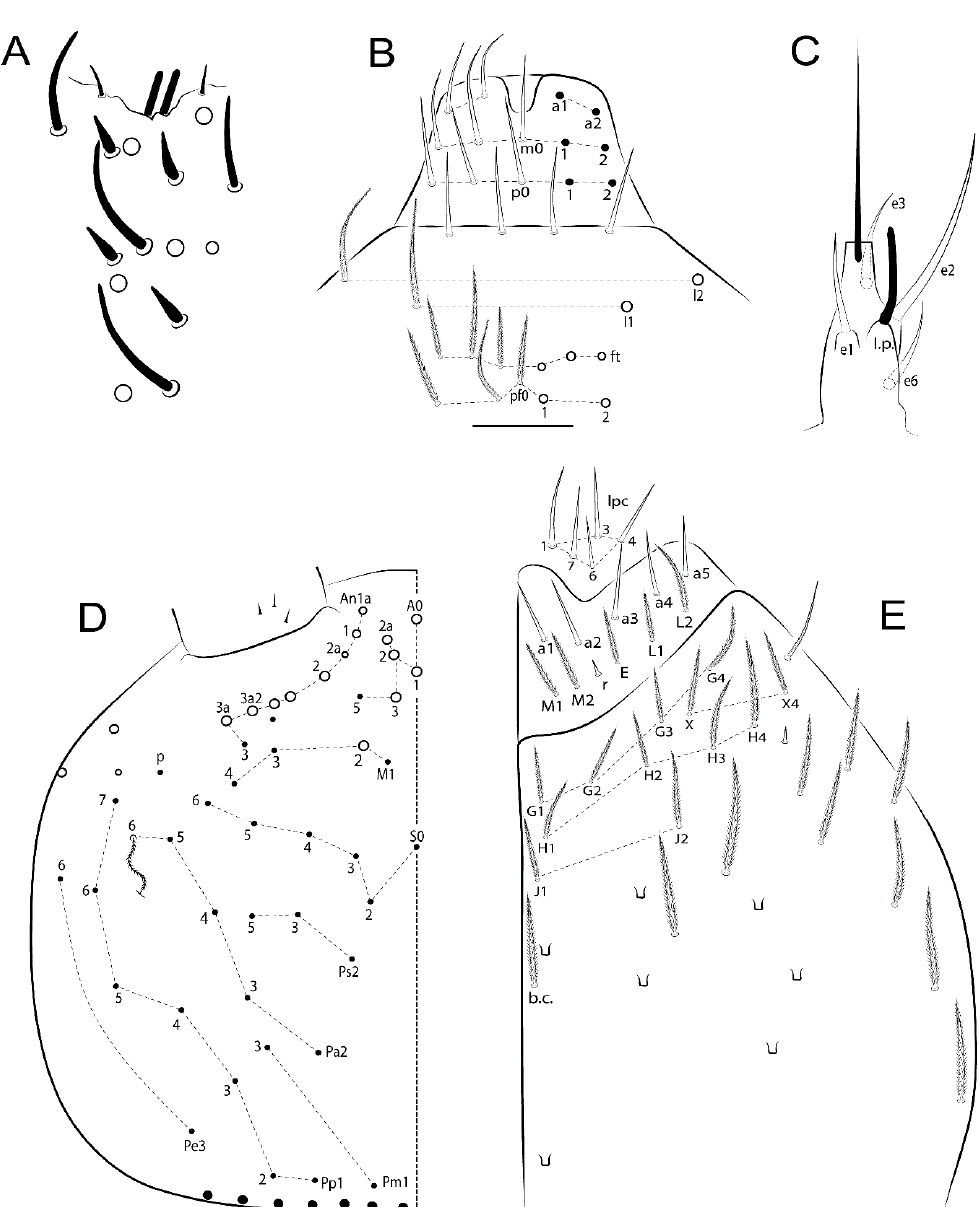
new species di ff ers by unguis m.t. present and unguiculus pe lamellae with outer tooth, both features absent in P. goughi [50]. absent in P. goughi [50].